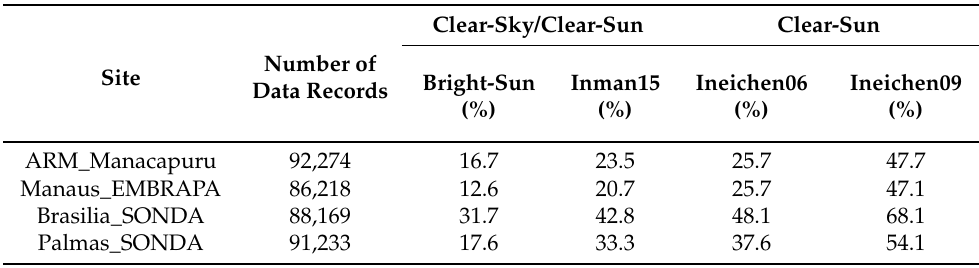
Table 2. Data fraction in each ground site flagged as clear-sky or clear-Sun by the four methods. Second column shows the total number of data records available for the